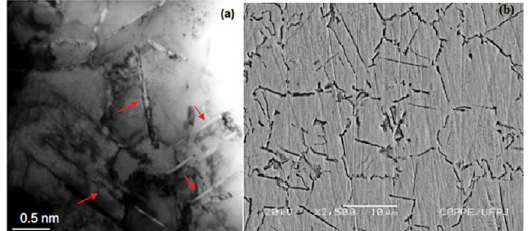
Ce IO 6 0.97 0.03